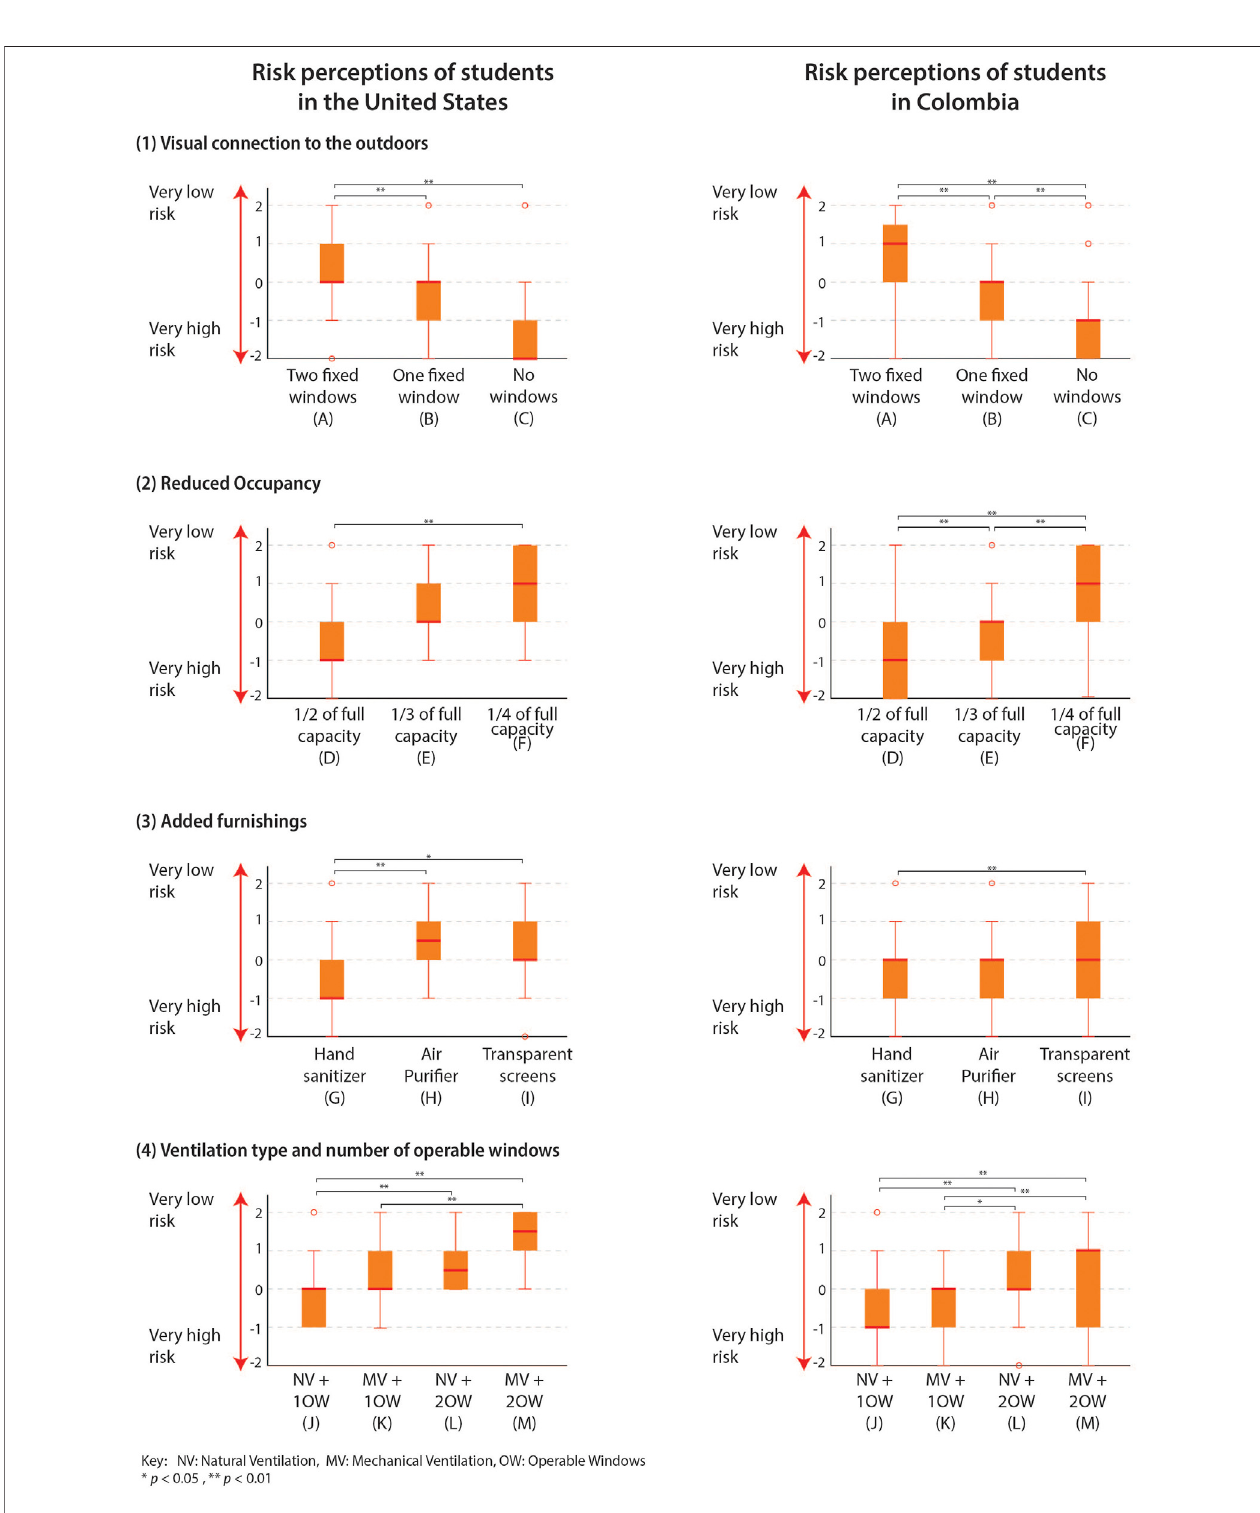
FIGURE 4 | Signi fi cant differences between scenarios in each category in the United States. Signi fi cant differences noted with brackets within each graphic. ** represents p < 0.01, * represents p < 0.05. NV (cid:1) Natural Ventilation, MV (cid:1) Mechanical Ventilation, OW (cid:1) Operable Windows.